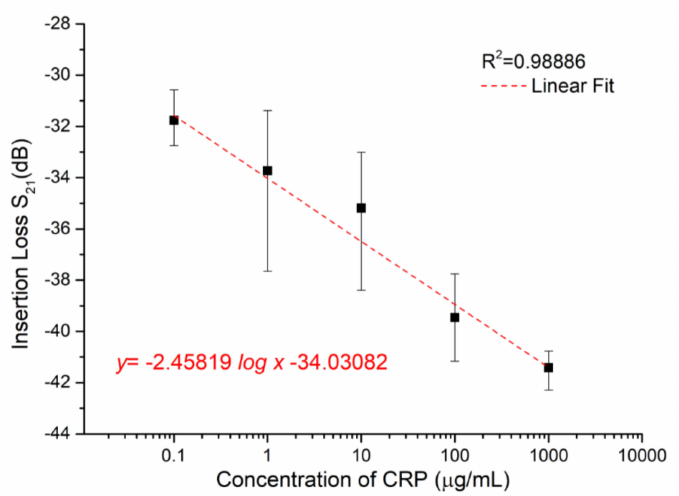
Figure 6. The correlation of amplitude attenuation and CRP concentrations of SAW